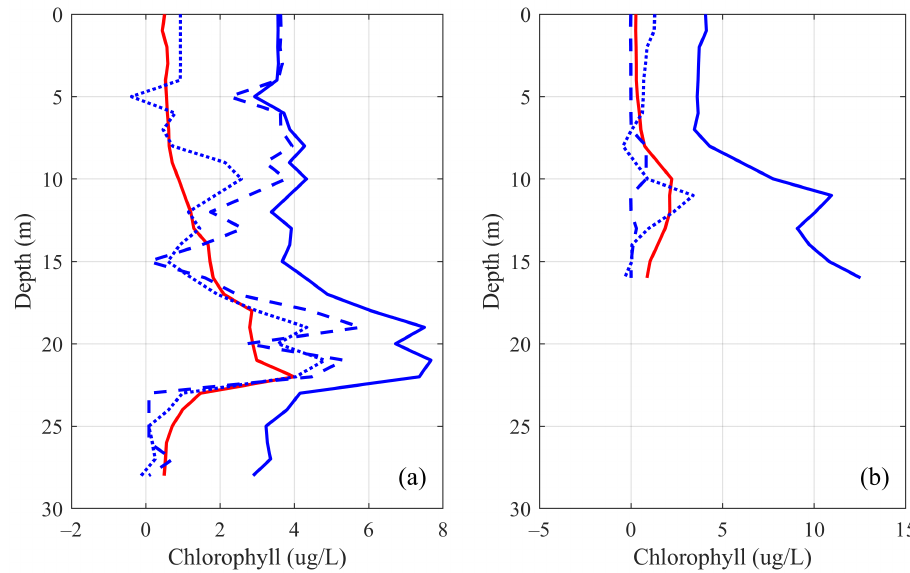
Figure 8. Simulated comparison of the retrieval and true results at ( a ) S1 and ( b ) S2. Three kinds of retrieval methods are utilized, including (1) dual-wavelengths at 532 and 412 nm, (2) dual-wavelengths at 532 and 440 nm and (3) single wavelength at 532